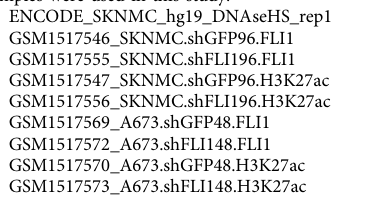
listed in Supplementary Table 2. The thermal conditions for touchdown (TD)-PCR protocol were as follows: Initial denaturation: 95 °C for 2min; denaturation 98 °C for 10 s; annealing: 59 − 49 °C for 30s ( T m ( = 59 °C) − 5 °C + 10 °C higher for TD- PCR); − 1°C every 2 cycles); extension: 72 °C for 1min (2× 10 cycles, and sub- sequently another 20 cycles at an annealing temperature of 65 °C); fi nal extension: 72°C for 5 min. These fragments were cloned upstream of the SV40 minimal promoter into the pGL3 luciferase reporter vector (Promega, #E1761, Germany) by In-Fusion HD Cloning Kit (Clontech, Japan) according to the manufacturer ’ s protocol. These vectors were used for transformation of Stellar Competent Cells (Clontech); successfully transformed bacteria were selected using ampicillin (Merck). Correct insertion of the vector was con fi rmed by colony PCR. The number of consecutive GGAA-repeats for each allele and each cell line was determined by commercial Sanger sequencing. The sequencing primer is listed in Supplementary Table 2. The presence of additional genetic variation in the cloned sequences apart from the SOX6 -associated GGAA-mSat was ruled out by whole- genome sequencing of the parental cell lines and con fi rmatory Sanger sequencing of the cloned fragments. For reporter assays, 5× 10 4 A673/TR/shEF1 cells per 24- well were seeded in 600µl medium and transfected with pGL3 luciferase reporter vector and Renilla pGL3-Rluc (ratio, 100:1) using Lipofectamine LTX Reagent with PLUS Reagent (Invitrogen). Four hours after transfection, the culture media was replaced by media with/without (w/o) Doxycycline (Dox; 1 μ g/ml; Merck). Cells were lysed after 72 h and monitored with a dual luciferase assay system (Berthold, Germany). Fire fl y luciferase activity was normalized to Renilla luciferase activity.